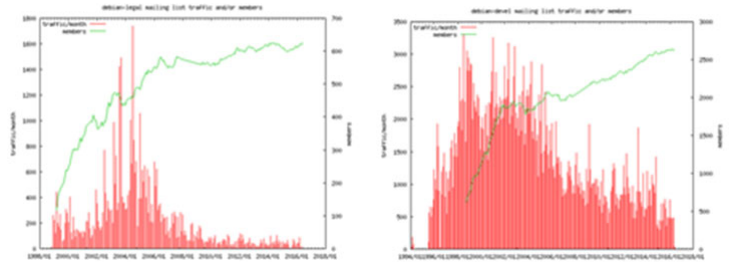
Figure 2. The comparison of debian-legal and debian-devel Source: Debian